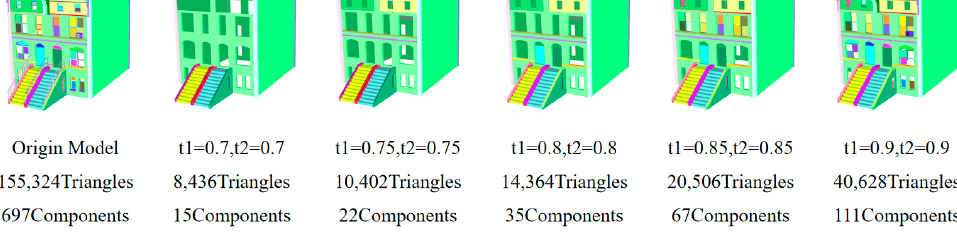
Figure 17. The influence of t1 and t2 on the appearance of the building with several separately modeled walls.